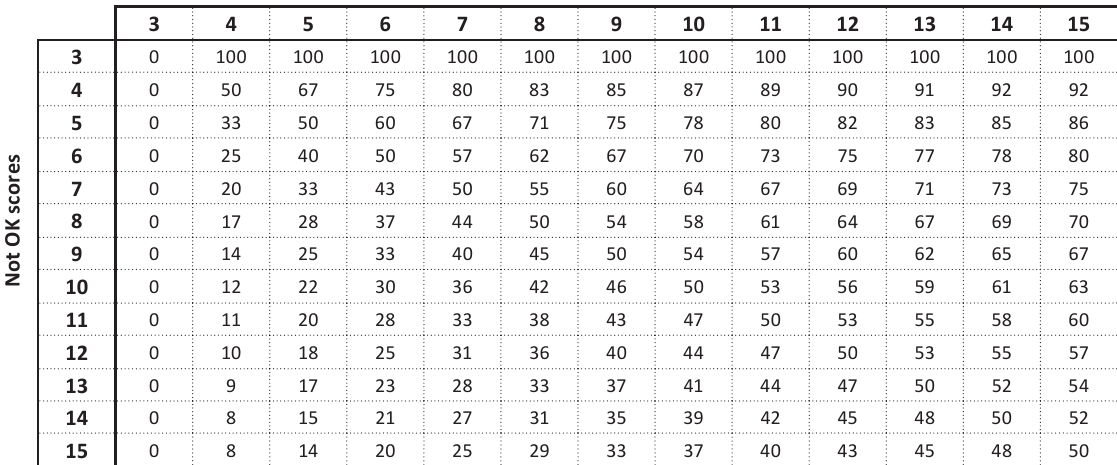
Table А2. OEQ norms